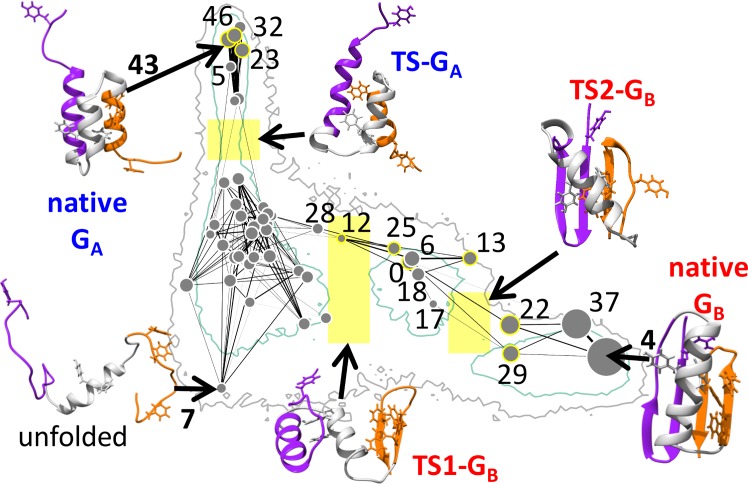
Clustering analysis of GA98 and GB98 suggests putative folding trajectories.50k-means clusters were obtained from a combined pool of 40,000 randomly sampled GA98 and GB98 conformations (Methods). The positions of their centroids are indicated on the QA/QB plane. Each centroid is represented by a grey filled circle of size commensurate with the number of conformations in the given cluster. Included in the background, as a positional reference, is the GA98 free energy landscape (Fig 3a). The clusters are numbered arbitrarily from 0 to 49. In the interest of readability, only number labels for selected clusters deemed to be important for the sequences’ folding pathways are shown. The centroid conformation is depicted for some clusters. A pair of centroid positions is connected by a line if their distance measure RMSDsm ≤ 5.75 Å (Methods). Increased thickness/darkness of the connecting lines indicates that the connected centroid conformations are structurally more similar with smaller RMSDsm. Conformations in the yellow boxes are taken to constitute a single putative transition state TS-GA for GA folding and two putative transition states TS1-GB and TS2-GB for GB folding. The TS-GA, TS1-GB, and TS2-GB regions encompass, respectively, 452, 834, and 805 of the 40,000 sampled conformations. The centroid structure of each putative transition state (TS) is exhibited to illustrate the structural characteristics of the TSs; but it is important to note that the putative TS ensembles are structurally diverse (S14 Fig). This property is reflected by the fact that the conformations in each TS ensemble belong to multiple clusters. The three clusters (nos. 43, 46, 23) that contribute most conformations to TS-GA account for only 38% of the TS-GA ensemble. The three clusters that contribute most to TS1-GB and TS2-GB (nos. 0, 25, 12 and nos. 22, 29, 13) account for 36% and 64% of their respective ensembles. We mark each of these most TS-related clusters by a yellow ring around the grey circle representing the cluster’s centroid position. In the conformational drawings, parts of the chain corresponding to β-hairpin 1 (residues 1–20) and β-hairpin 2 (residues 42–56) in the native GB fold are highlighted, respectively, in purple and orange. Shown as sticks are aromatic residues to be considered further below for possible participation in π-interactions. The positions of these aromatics also serve to highlight the locations of the main hydrophobic regions in the folded and partially folded conformations shown.